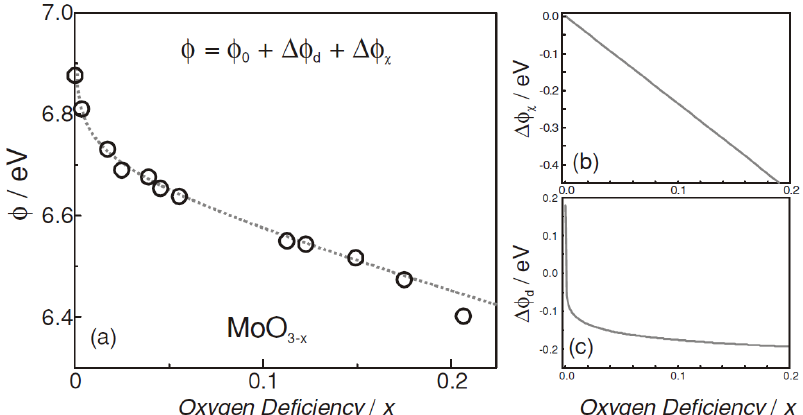
Figure 6. ( a ) Plot of oxygen deficiency (vacancy) and work function ( ϕ ). ϕ 0 is the work function of MoO 3 , and the work function of MoO x decreases with the increase of oxygen deficiency, which re- sults from ( b ) low electronegative cation, causing work function change (Δϕ χ ) and ( c ) donor state, causing work function change (Δϕ d ) [125].